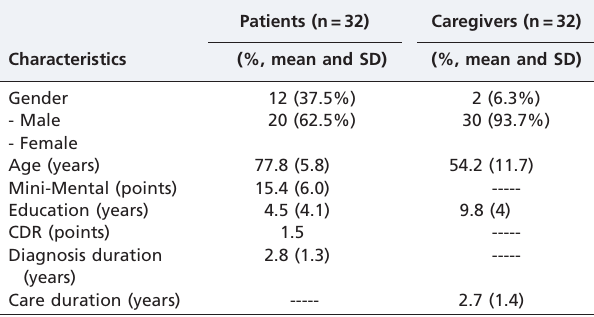
Table 1 - Socio-demographic and clinical aspects of 32 patients with Alzheimer’s disease and their respective caregivers at baseline (percentage, mean and standard